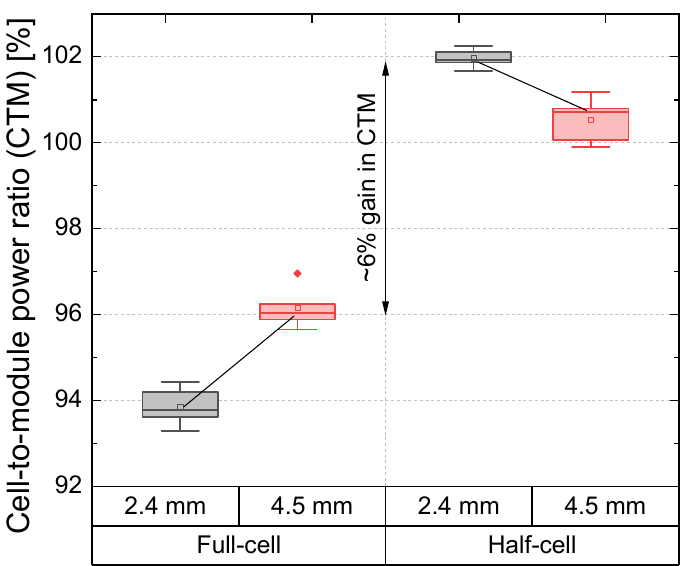
Figure 8. Cell-to-module power ratio of 100 PV modules (25 per each group) with full-cell and half- cell designs and two total tab widths of 2.4 mm and 4.5 mm.